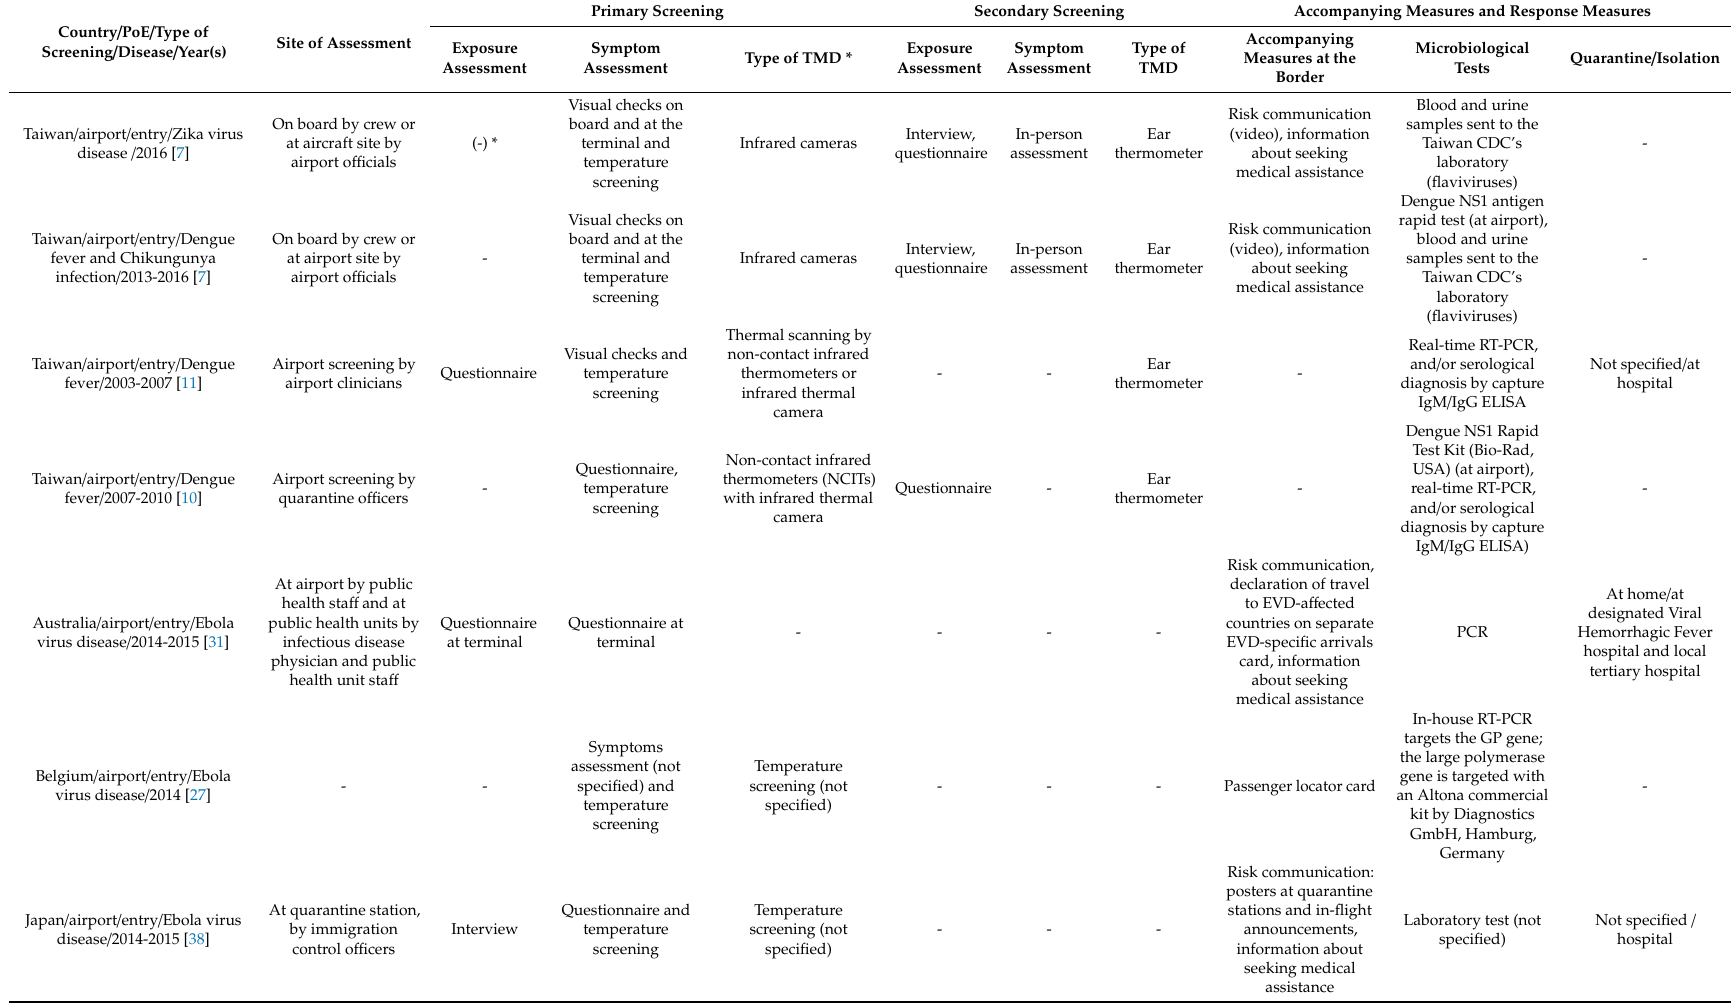
Table 6. Screening methods and accompanying